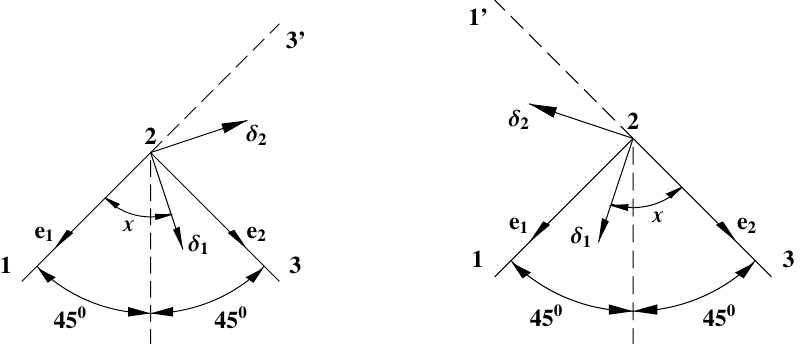
Figure 2. The formation of twin, χ = 46.8 ◦ ; twin occurs from element 1 2 3 (cid:48) in direction of vector δ 1 to position 2 − shifting its part 1 (cid:48) 2 in the direction of vector δ 1 to position 1 −